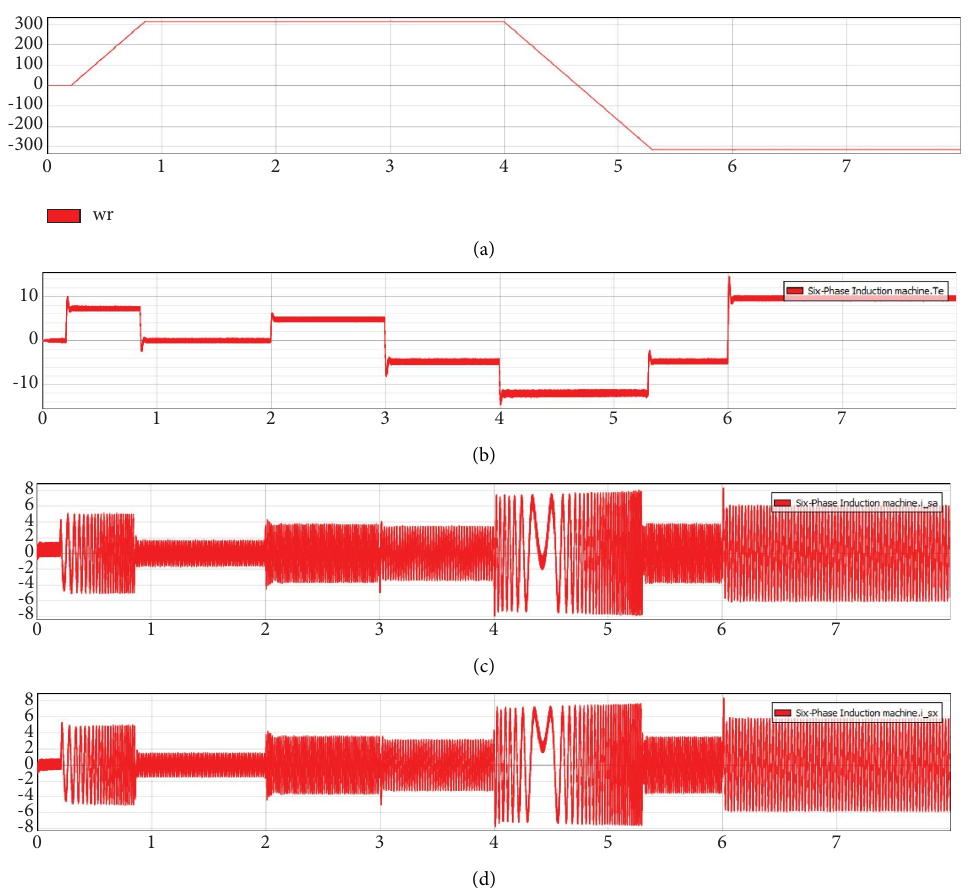
Figure 13: Real-time test results of four quadrant operation: (a) rotor speed; (b) developed torque; (c) winding current of phase a ; (d) winding current of phase x